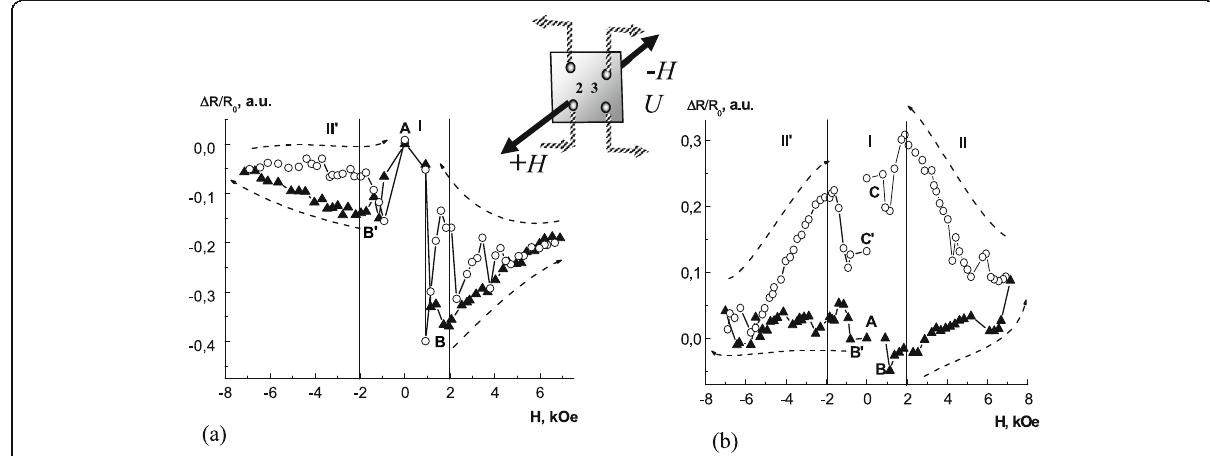
Fig. 4 The dependencies of the magnetoresistance Δ R / R ( H ). a For sample #1, black triangle - increasing magnetic field; white circle - diminishing magnetic field. b For sample #3, black triangle - increasing magnetic field; white circle - diminishing magnetic